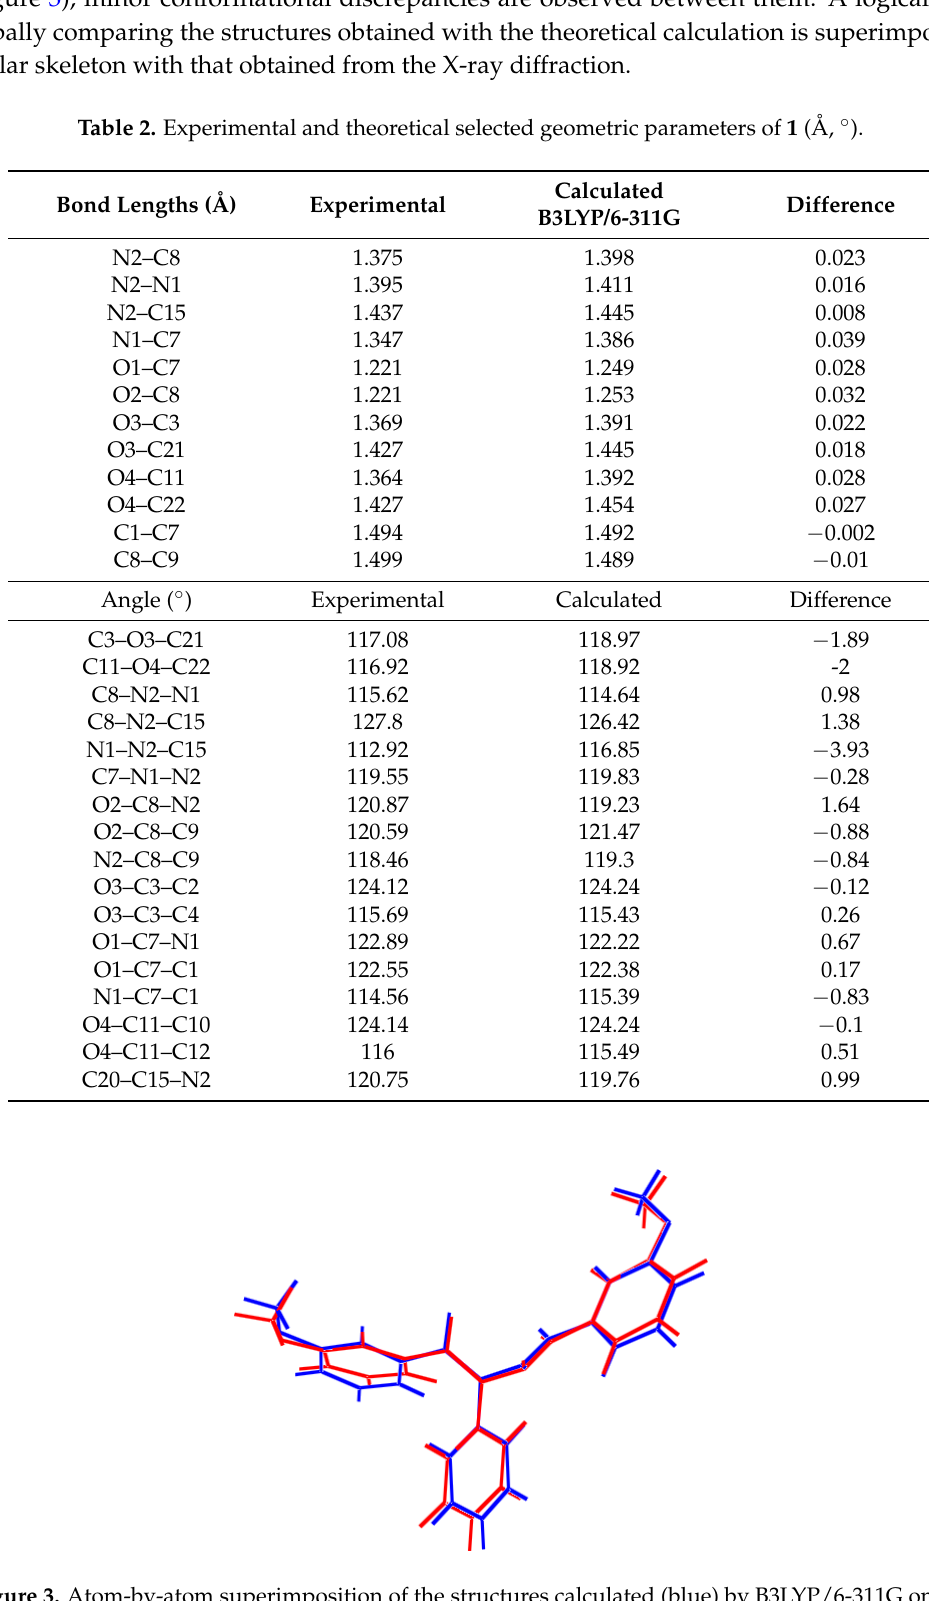
Figure 3. Atom-by-atom superimposition of the structures calculated (blue) by B3LYP/6-311G on the X-ray structure (red) of the title compound.